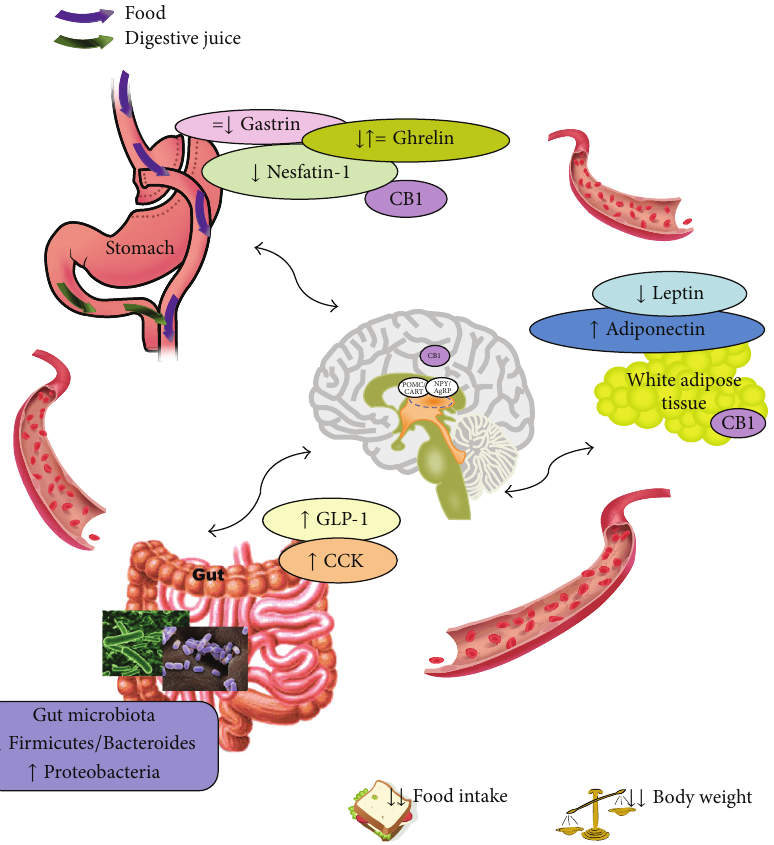
Figure 1: The figure represents the major organs involved in the modulation of peripheral signals (ghrelin, nesfatin-1, gastrin, leptin, adiponectin,GLP-1,CCK,andgutmicrobiota)afterRoux-en-Ygastricbypass(RYGB)surgery.Theincrease/decreaseinthesignalsisdesigned by arrows. CB1: cannabinoid receptor type 1; CCK: cholecystokinin; GLP-1: glucagon-like peptide